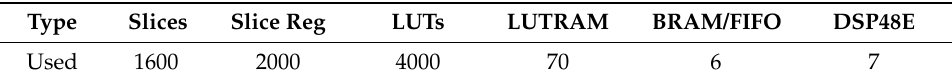
Table 2. Algorithmic resource consumption.